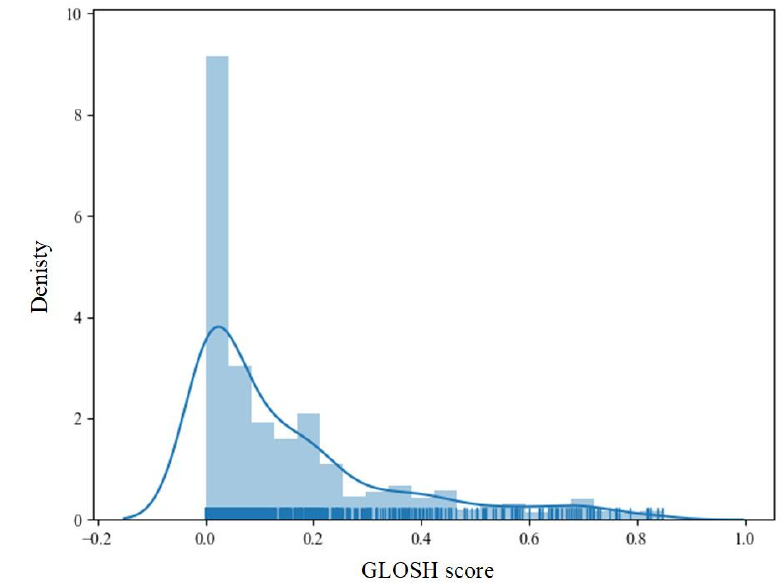
Figure 12. Bar graph of GLOSH score.